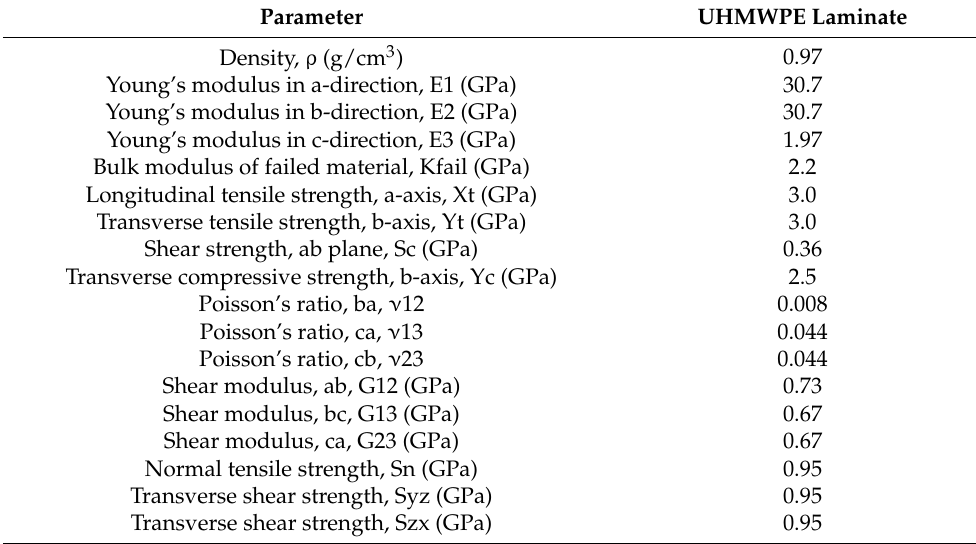
Table 6. Parameters of the UHMWPE laminate